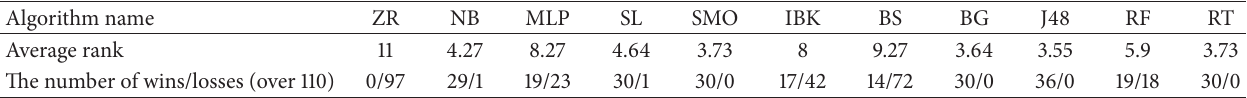
Table 9: The average ranks of the algorithms over 11 datasets “and the sum of